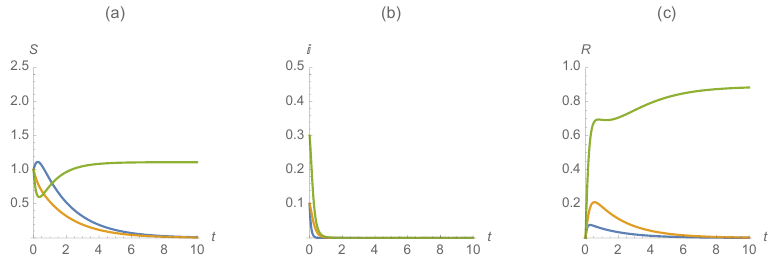
Figure 8. ( a ) S j , ( b ) I j , and ( c ) R j . The first disease is represented in blue, the second in orange and those with susceptible/infected/recovered by diseases in